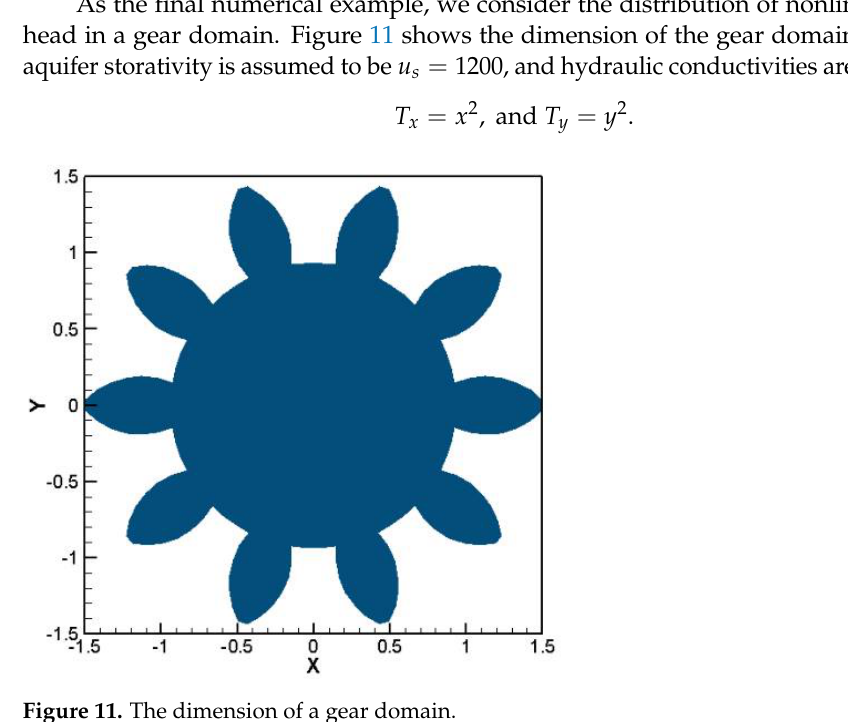
As the final numerical example, we consider the distribution of nonlinear hydraulic head in a gear domain. Figure 11 shows the dimension of the gear domain. The specific aquifer storativity is assumed to be u s = 1200, and hydraulic conductivities are the following: